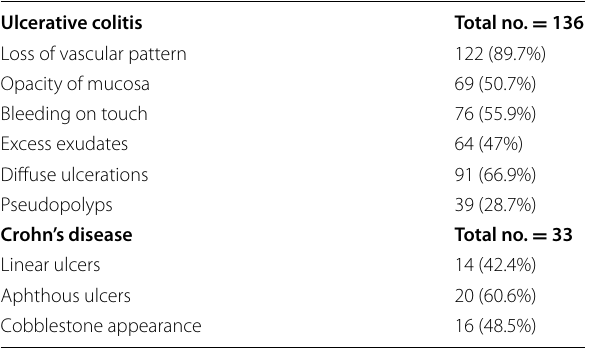
Table 7 Colonoscopy findings (at index presentation) in our